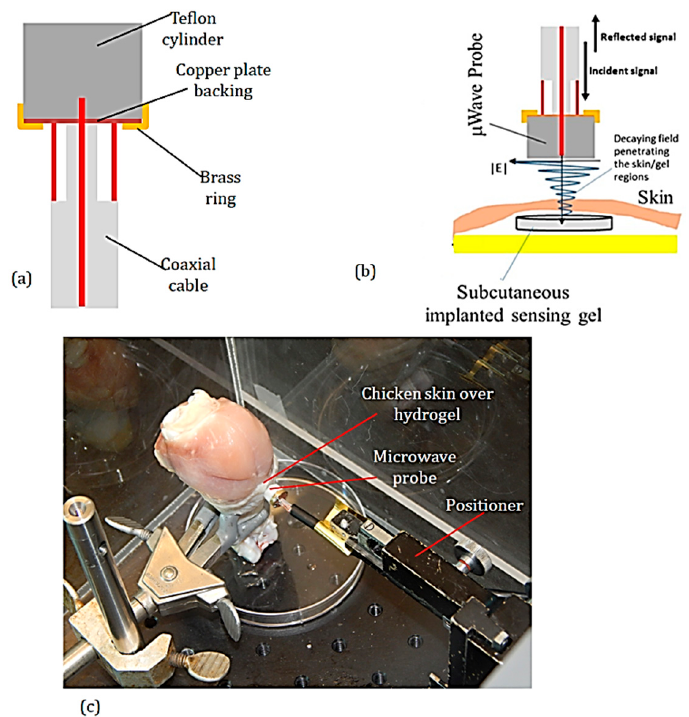
Figure 5. Remote microwave probing of hydrogel. ( a ) Schematic of the Teflon microwave probe for remote microwave monitoring of hydrogel response. ( b ) Schematic of setup for monitoring hydrogel response through chicken skin. The field distribution of the decaying microwave fields is perturbed when hydrogel swells or de-swells. This results in changes in the S 11 of the probe. ( c ) Photograph of setup for monitoring hydrogel response through the skin of a chicken drumstick.